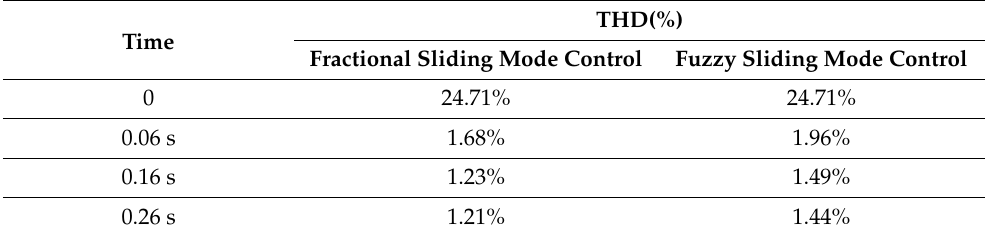
Table 2. THD in the proposed controller and a normal controller. Figure 12. DC capacitor voltage with an increasing load.